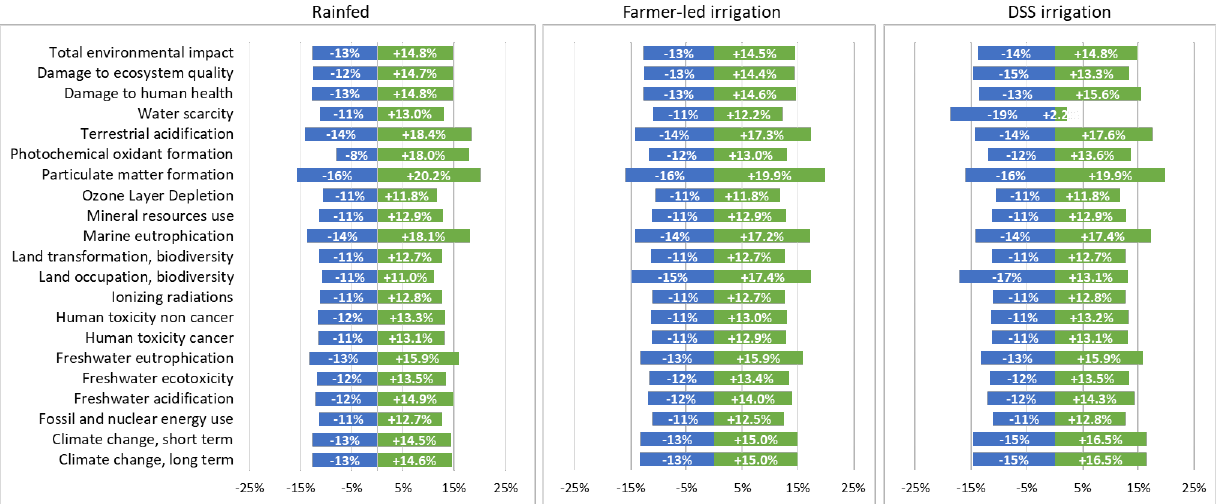
Figure 6. Monte Carlo uncertainty analysis of olive cropping system representing uncertainty per impact category using the IW+ method.